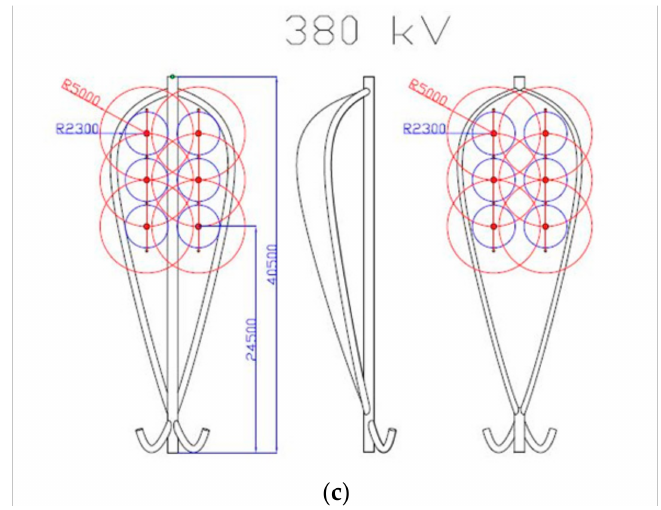
Figure 10. Preliminary set up of the 3D CAD model for the 380-kV line. ( a ) Capestrano Warrior statue; ( b ) Eagle; ( c )